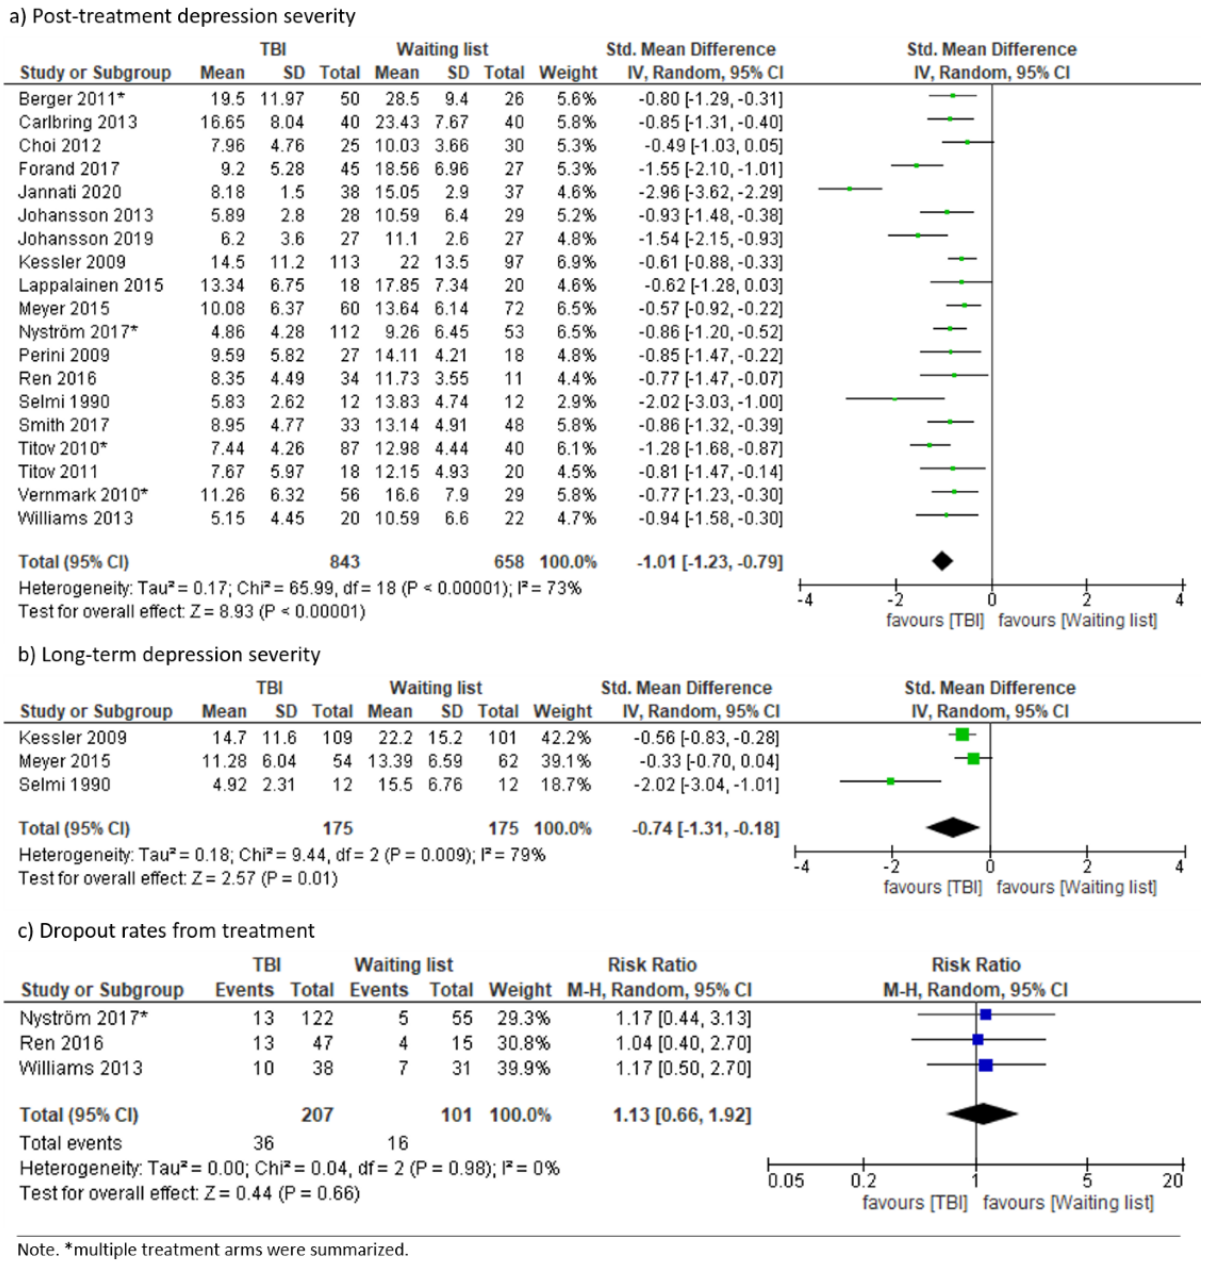
Figure 7. Forest plots on technology-based psychological intervention versus